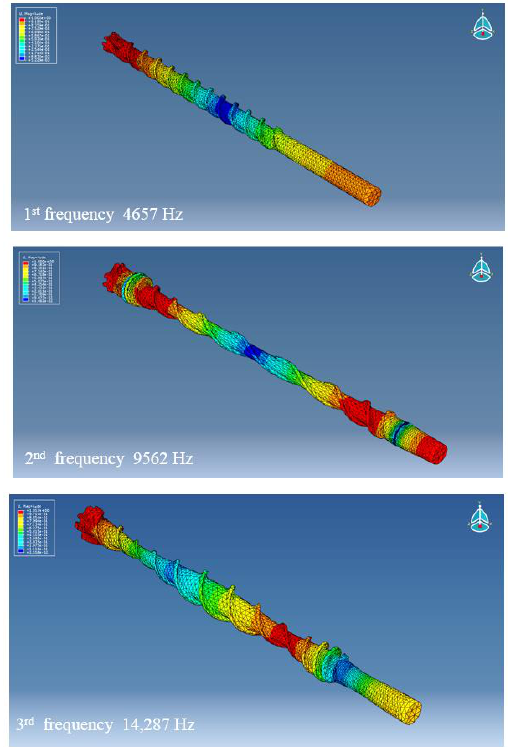
Figure 5. The first three axial modes of vibration for the drill bit FE model.